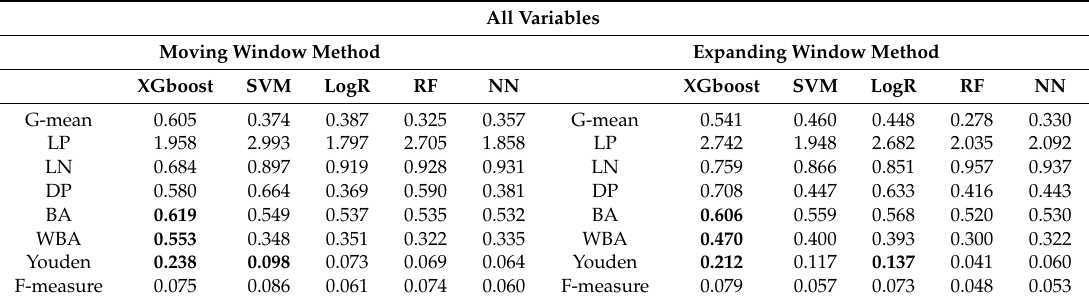
Table 7. Verification methods: Dependent variable concerns a US natural gas crisis (all variables).